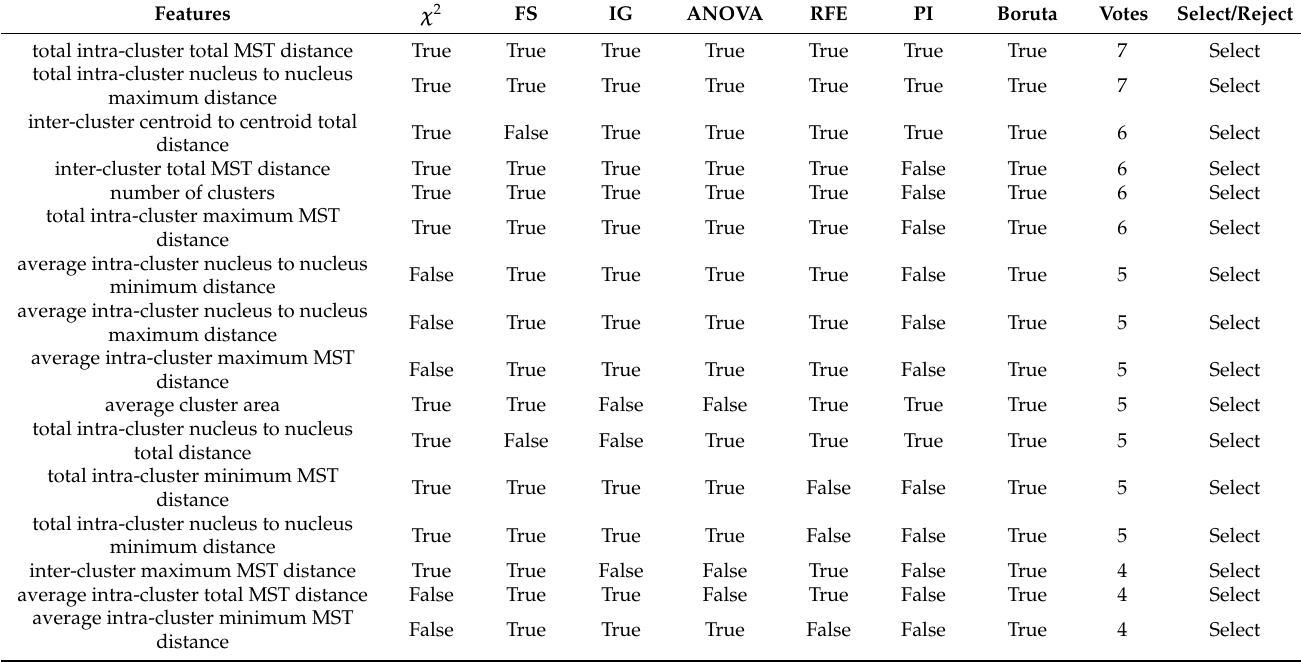
Table 2. Feature selection based on majority voting. The most significant features were selected based on majority “True”. True: Selected, False: Not selected, χ 2 : Chi-Square Test, FS: Fisher Score, IG: Information Gain, RFE: Recursive Feature Elimination, and PI: Permutation